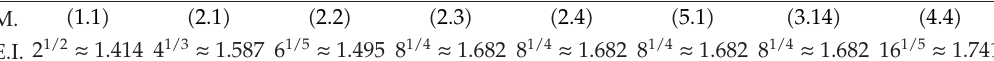
Table 1: Comparisons of e ffi ciency indices for di ff erent types of derivative-free schemes. M.